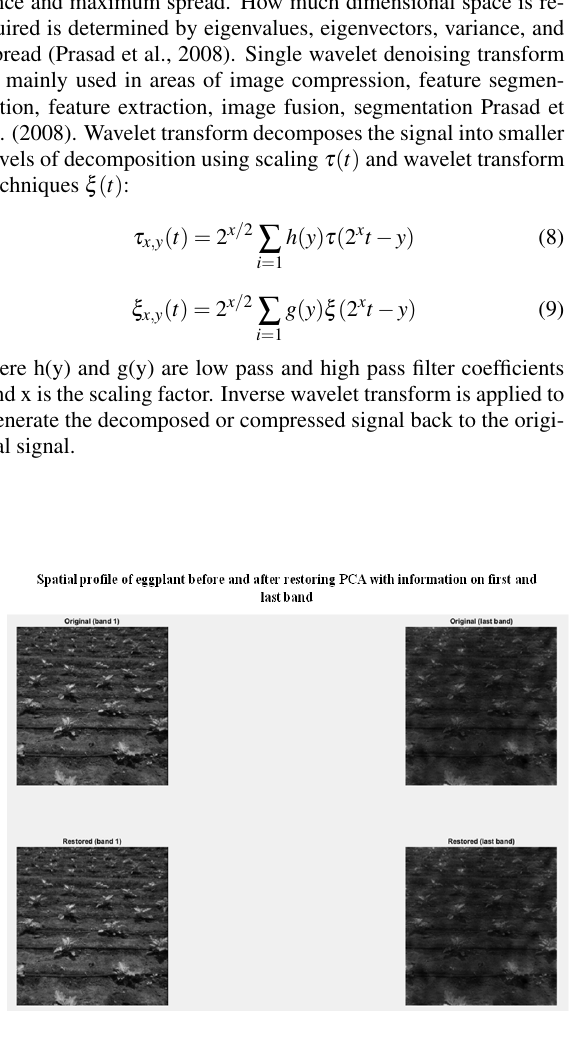
Figure 7: Spatial profile of eggplant before and after applying PCA + wavelet denoising